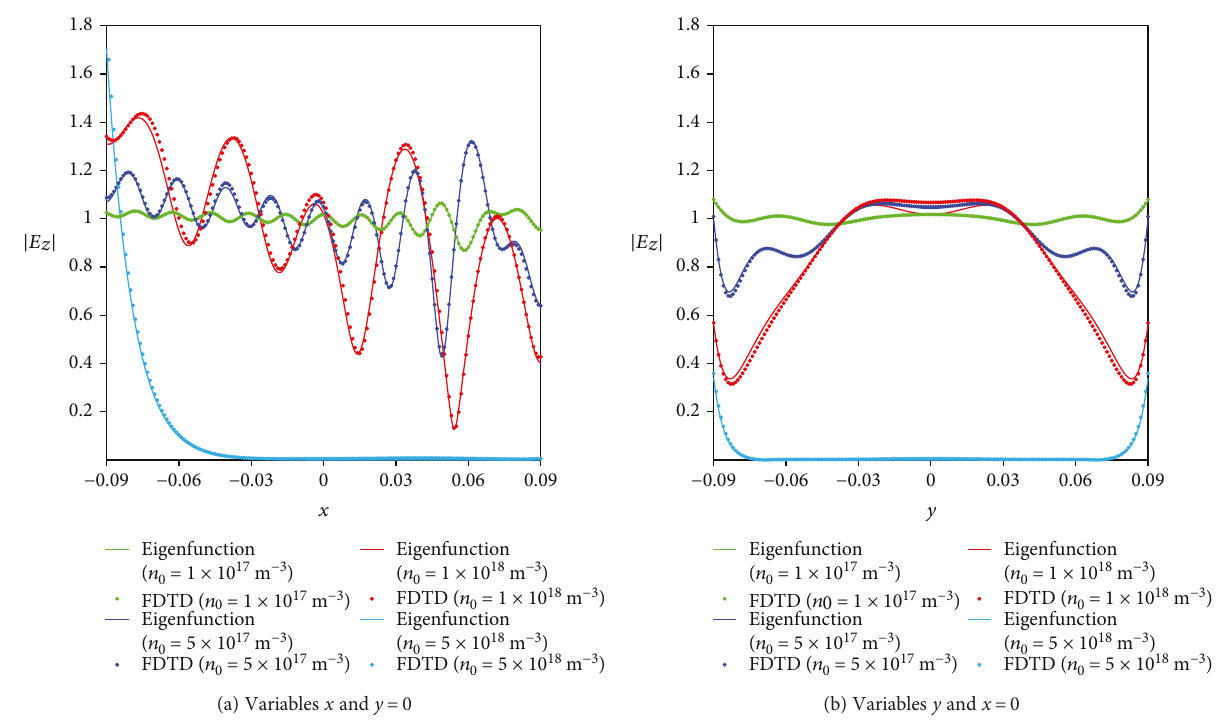
Figure 10: Comparison between the magnitude of the electric fi eld, in volts/meter, inside the plasma for linear cuts through the cylinder obtained by the eigenfunction method and the FDTD simulation for di ff erent electron densities; incident wave frequency is set to f =10 GHz, and electron collision frequency is set to ν =500 × 10 6 in